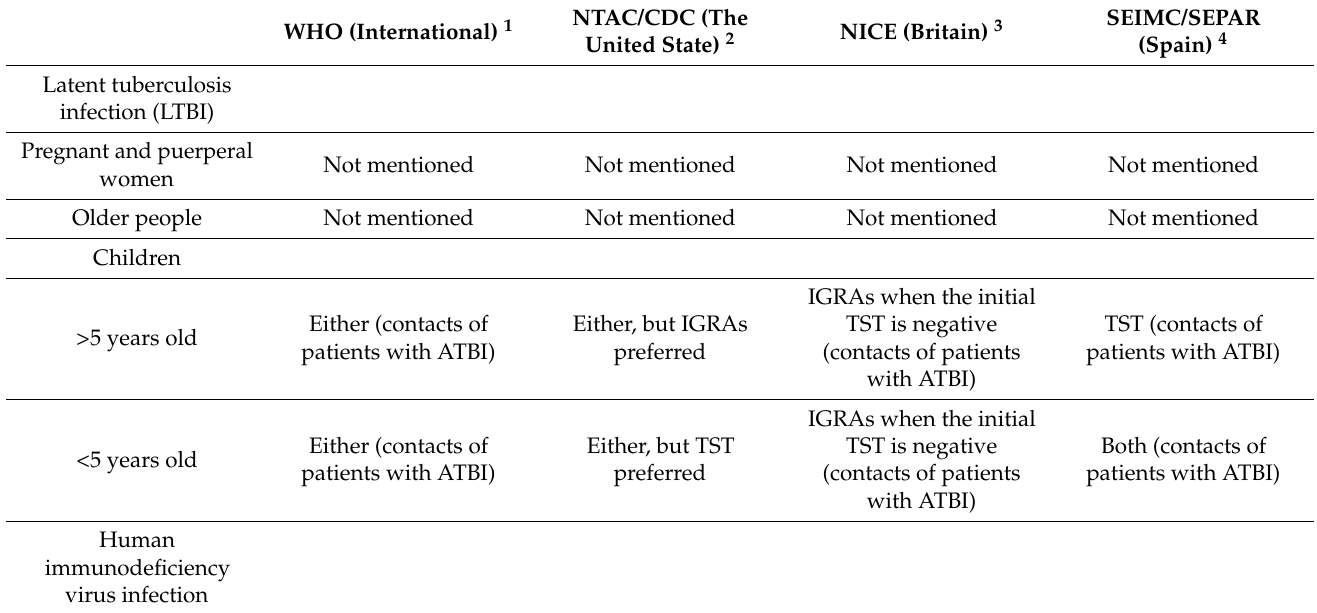
Table 1. Worldwide guidelines on recommendations of interferon-gamma release assays